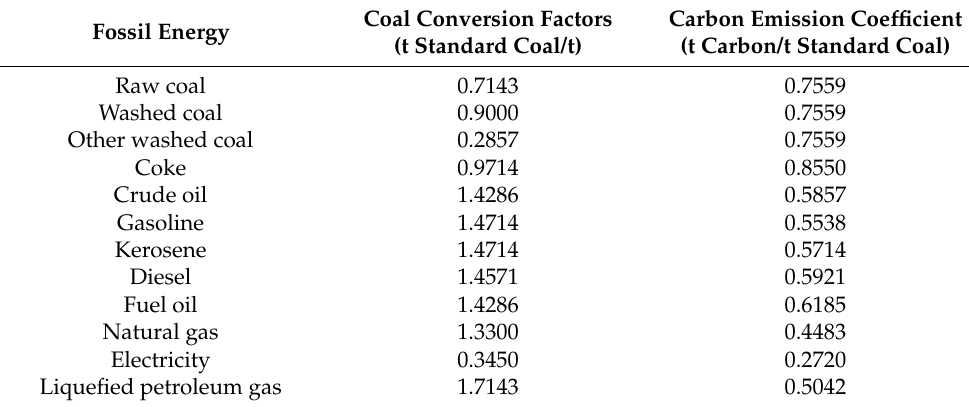
Table 2. The carbon emission coefficient of various energies. Coal Conversion Factors Carbon Emission Coefficient Fossil Energy (t Standard Coal/t) Raw